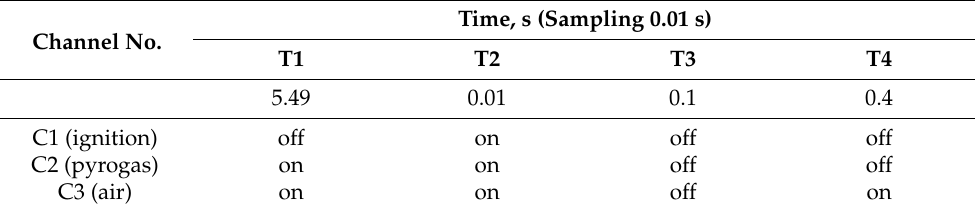
Table 6. Cyclogram of PDT operation. Channel